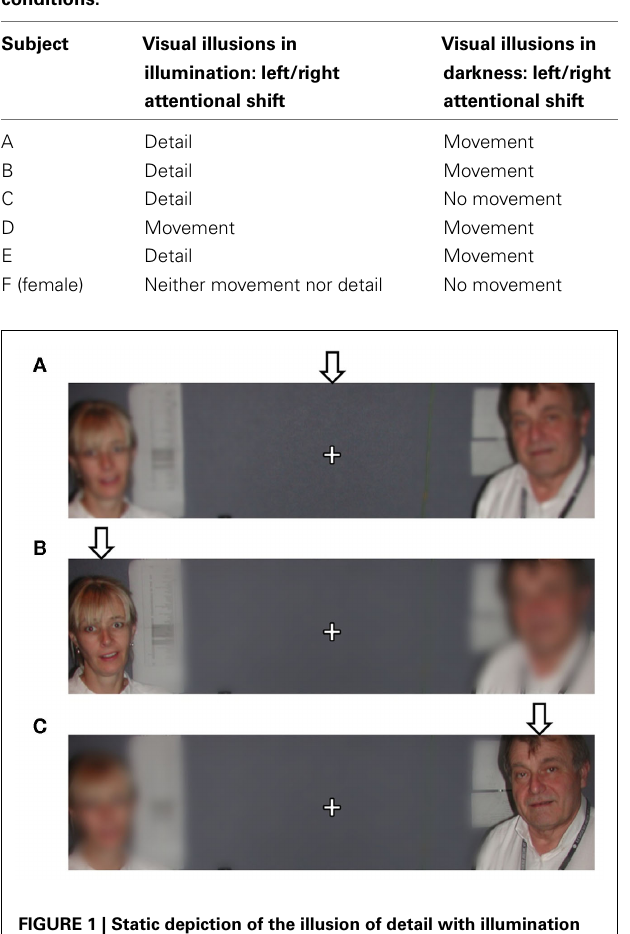
FIGURE 1 | Static depiction of the illusion of detail with illumination during paralysis. (A) When attending to the center of the foveal field (indicated by + ) subjects report poor detail of faces in the left and right periphery.When attending to either the left (B) or right (C) face (attempted gaze without actual movement of the foveal field due to paralysis) subjects report increased detail of the attended face.The arrows indicate the position of the attempted gaze.The supplementary material shows an animation of this depiction.